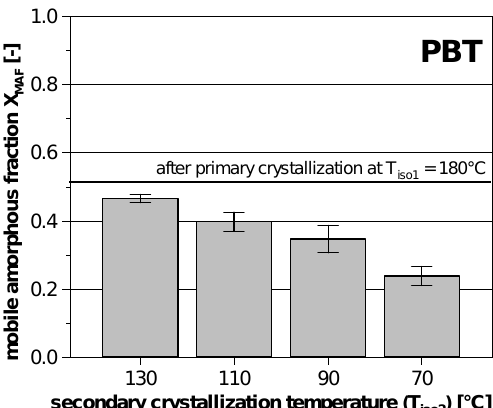
Figure 9. Evolution of the mobile amorphous fraction of PBT after secondary crystallization at different temperatures subsequent to the primary crystallization at 180 °C. The corresponding holding times were 90 s (180 °C) and 400 s (130–70 °C), respectively.